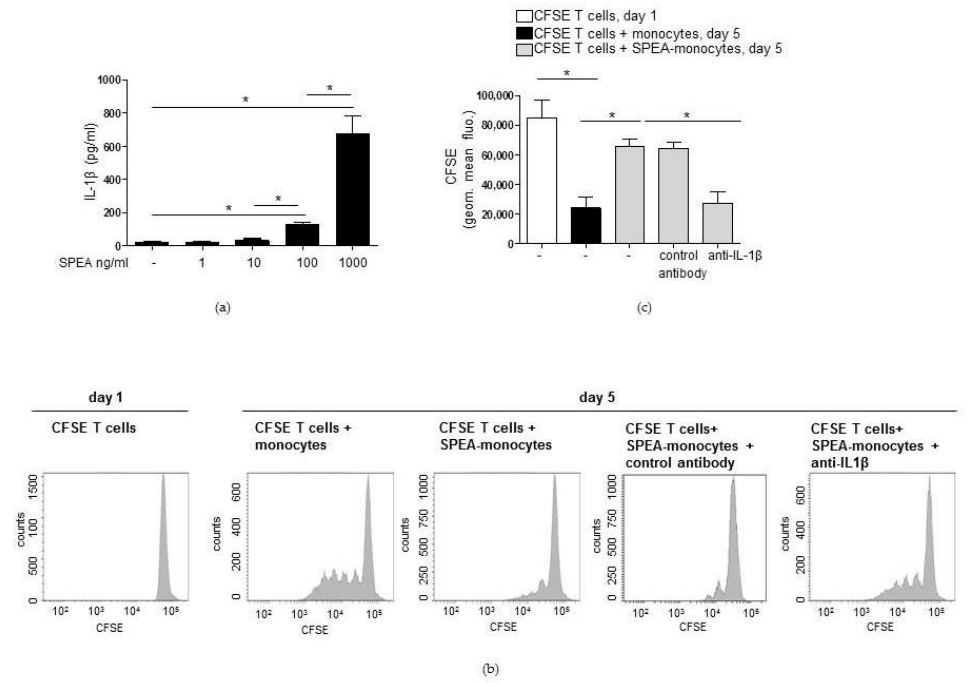
Figure 4. IL-1 β modulates SPEA-monocytes toward a T-cell suppressing phenotype. ( a ) Primary monocytes were stimulated with 1 ng / mL, 10 ng / mL, 100 ng / mL, or 1000 ng / mL SPEA for 48 h. Supernatant was collected and used for IL-1 β ELISA analyses. Columns represent the mean of three experiments + standard deviation (error bars). ( b ) Monocytes were stimulated with 1000 ng / mL SPEA for 48 h (SPEA-monocytes) or left unstimulated (monocytes). Additionally, cells were treated with 3 µ g / mL anti-IL1 β neutralizing antibody (anti-IL1 β ) or 3 µ g / mL of the respective isotope control (anti-IL1 β ). After two days, cells were washed and allogeneic CFSE-labeled CD4 T cells (ratio 1:2) were added. After five days, the CFSE (FITC) signal was analyzed on a FACSCanto. Shown are flow cytometer histograms of the CFSE (FITC) signal of T cells. ( c ) Quantification of ( b ) and two more experiments. The color of the columns shows whether the T cells were cultured alone for a day (white) or with unstimulated monocytes (black) or SPEA-monocytes (grey) for five days. Mean + standard deviation of n = 3. Statistical analysis: the comparison of two data groups was analyzed by Mann–Whitney U test with * p ≤ 0.05. The line above the columns depicts the compared